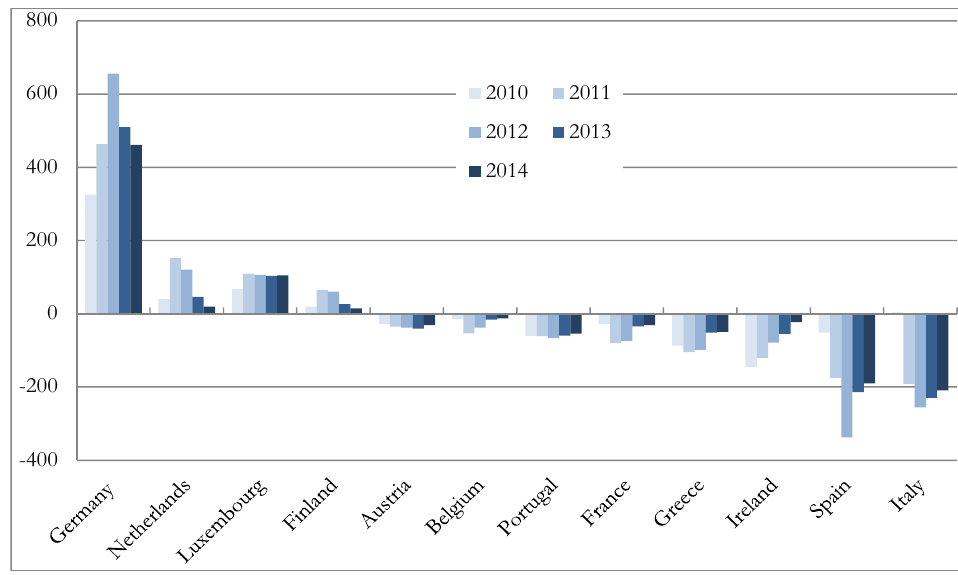
Figure 1. TARGET2 balances towards the Eurosystem, EMU-12 member States